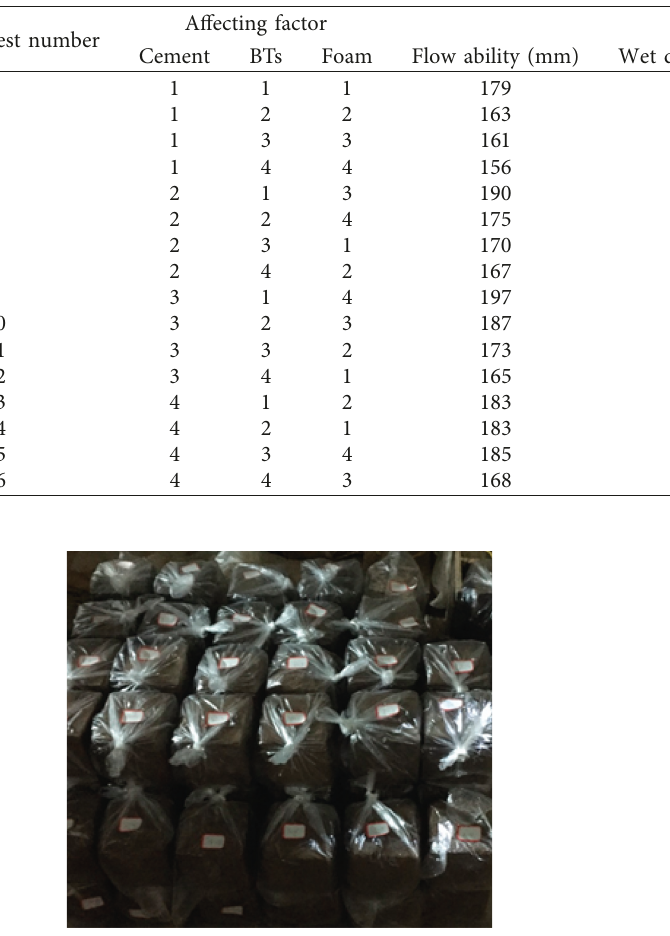
Table 4: Orthogonal table.